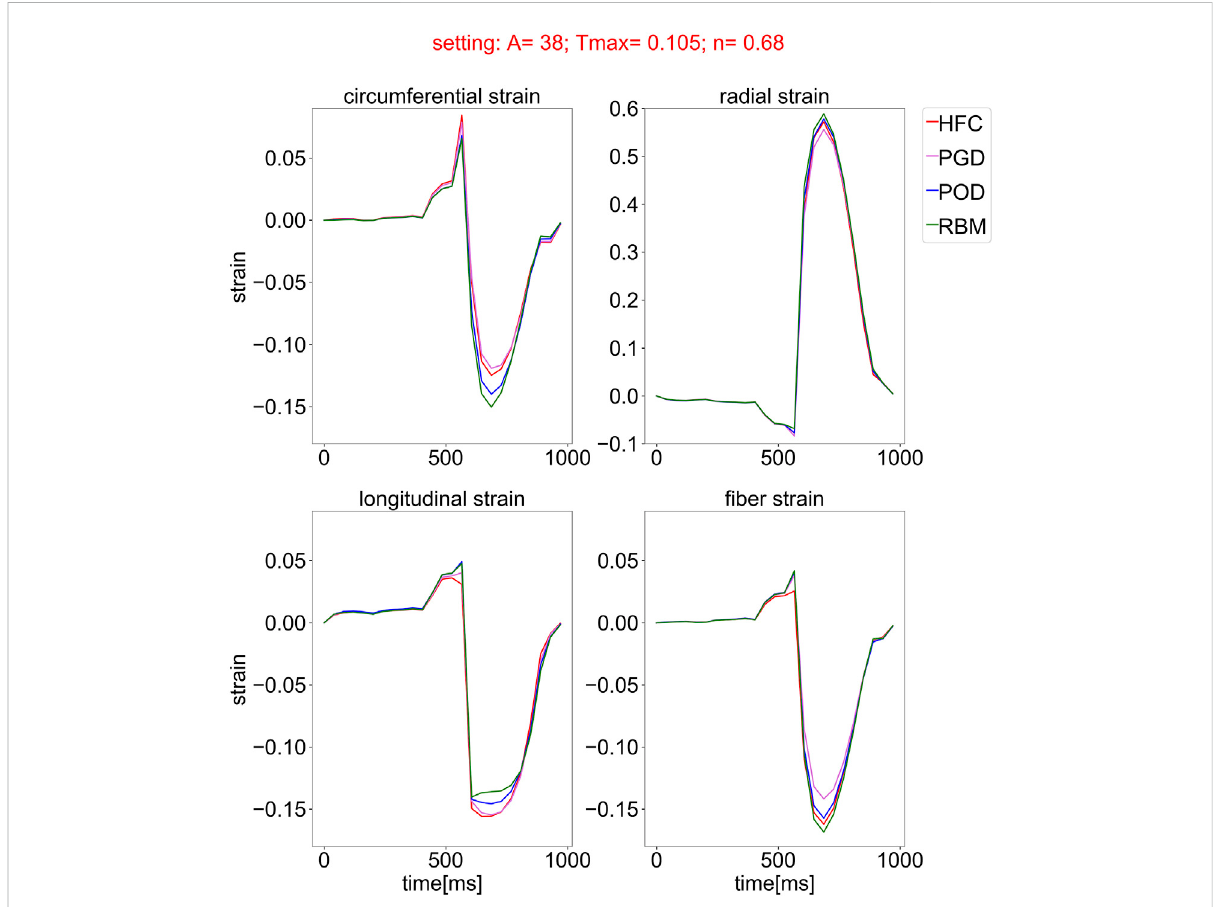
FIGURE 6 Simulatedstraincurvesoverthecardiaccycle,startingfromtheinitial stateindiastasisfor allmodelswiththefourdifferent fi ber fi elds,obtained by the compared interpolation methods (HFC: red, PGD: violet, POD: blue, and RBM: green) and simulated with one exemplary parameter setting optimized for the fi ber fi eld interpolated with the HFC method. The subplots show the median of the circumferential, radial, longitudinal, and fi ber strain over the myocardium, relative to the in fl ated state in